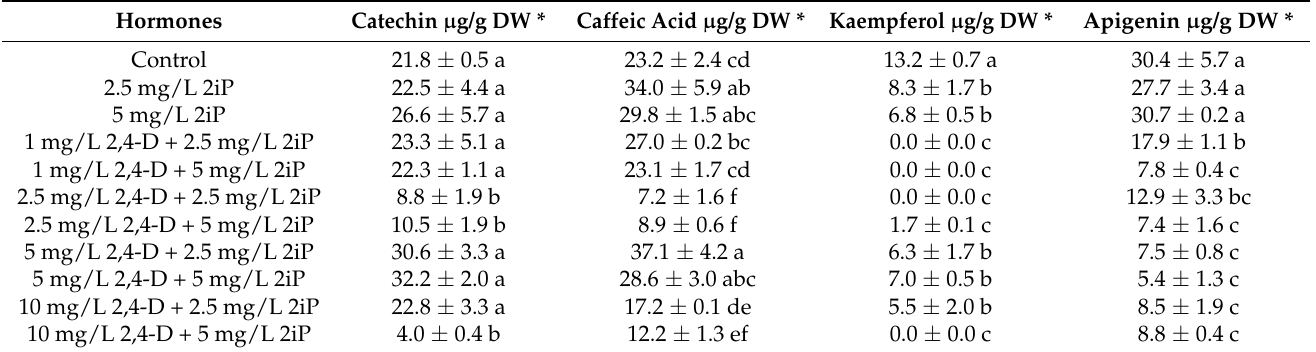
Table 2. Effect of 2iP and 2,4-D on polyphenol content accumulation in cell suspension of date palm at the eleventh week of